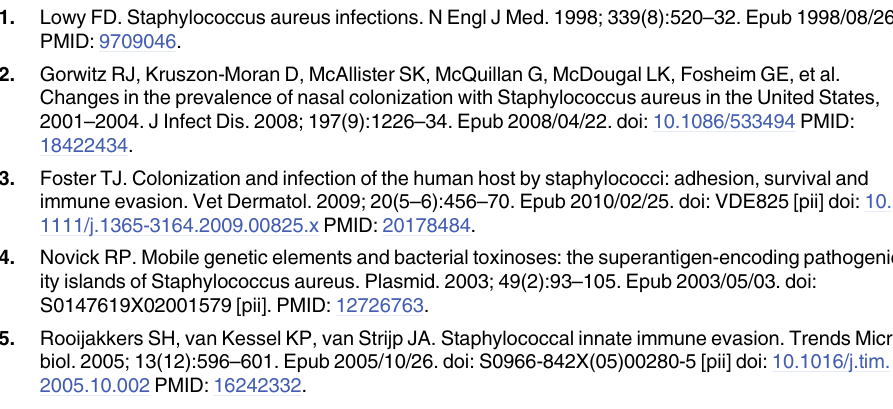
S2 Fig. Graphics of normalized C T values for qRT-PCR assays. Normalized cycle thresholds for n = 3 independent determinations for all figures presented in the text showing qRT-PCR data and prior to conversion to fold-change as described in Materials and Methods. The data are based upon the ct values presented in S1 Table. Each graphic displays Figure and corre- sponding probe used. S1 Table. Normalized C T values for all qRT-PCR